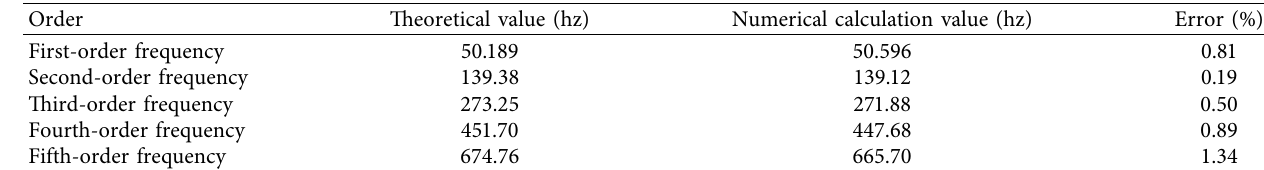
Figure 3: Schematic diagram of tube bundle structure and end face grid with internal flow. Table 2: Theoretical and numerical values for the natural frequency of single-span tube.